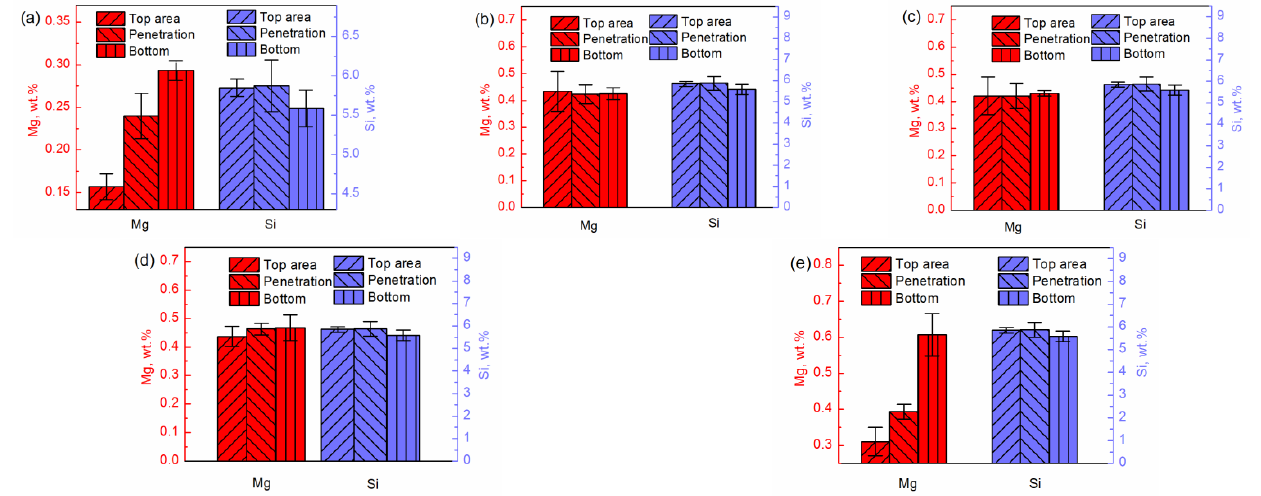
Figure 7. Concentrations of compositions Mg, Si in different weld zones. Heat input of ( a ) 122 J/mm; ( b ) 150 J/mm; ( c ) 177 J/mm; ( d ) 204 J/mm; ( e ) 231 J/mm.